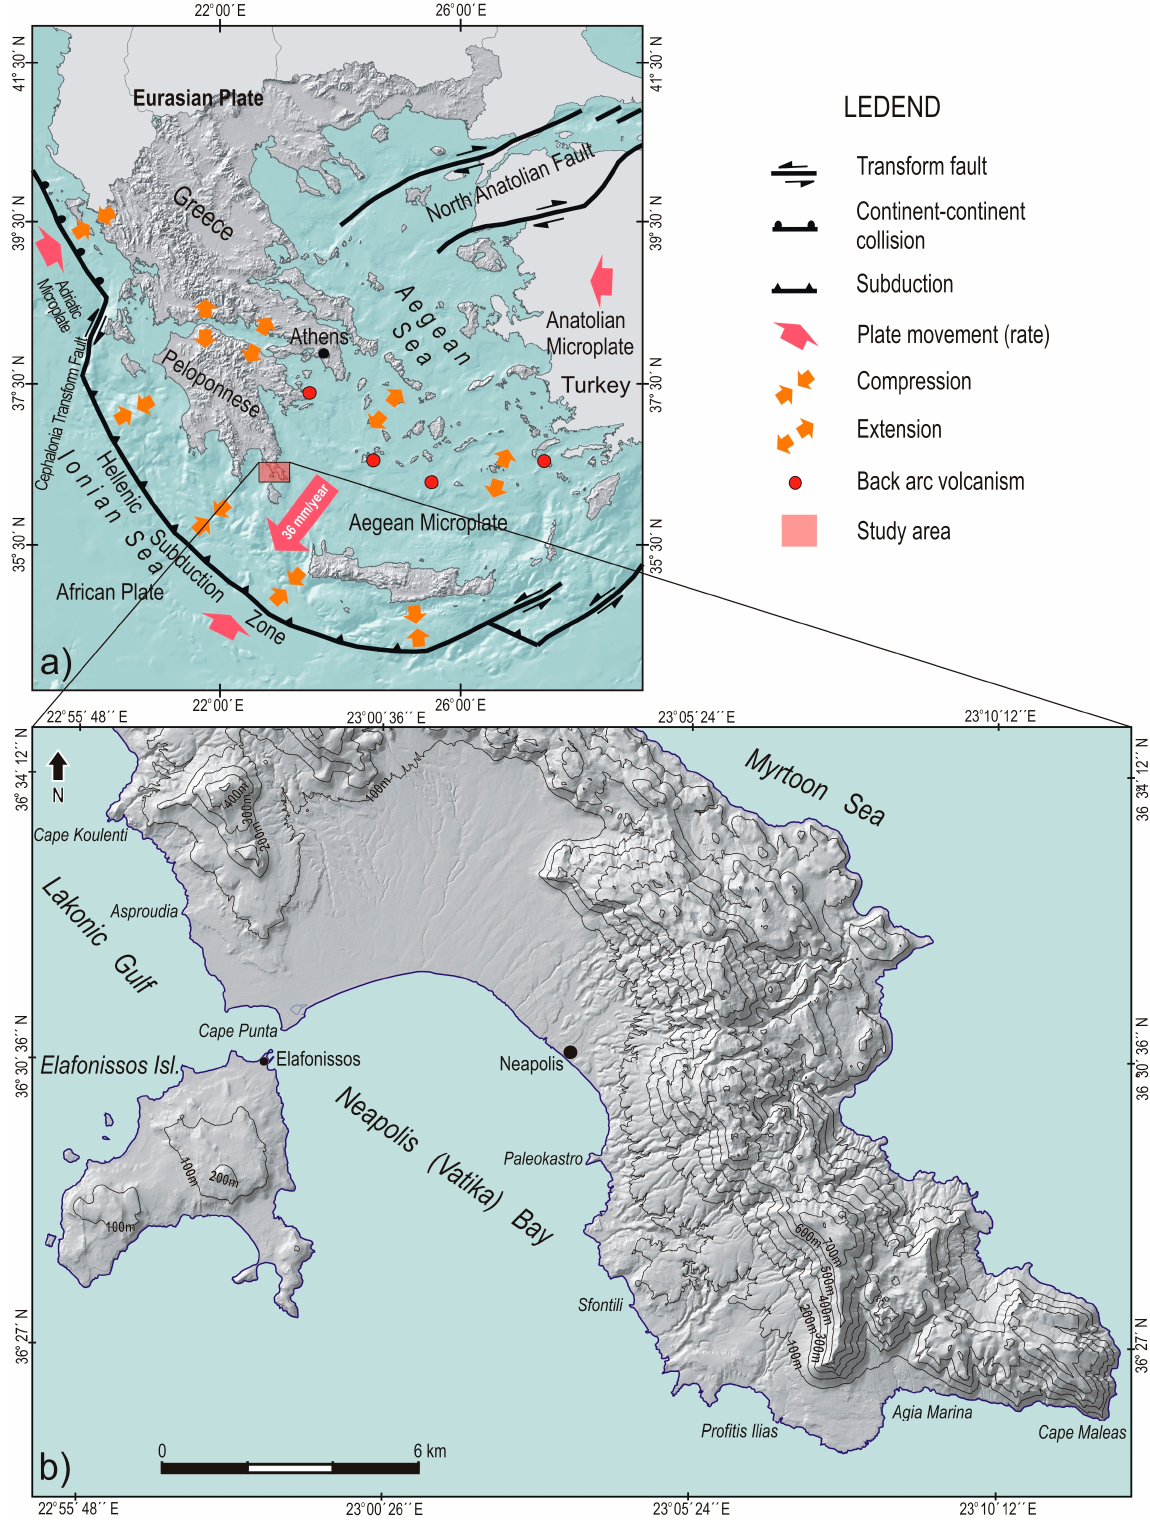
Figure 1. ( a ) The geotectonic setting of Greece (modified from Reilinger et al. [58], and Vott et al. [67]) depicting the location of the study area and ( b ) hill shaded map of the study area produced from topographic maps at 1:5000 scale of the Hellenic Military Geographical Service.